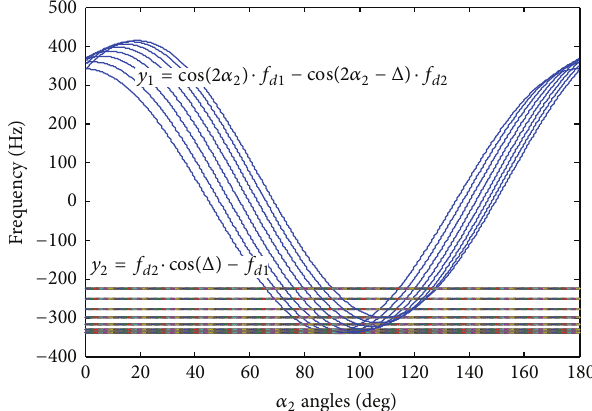
Figure 1: Relationship between mobile terminal and base station.